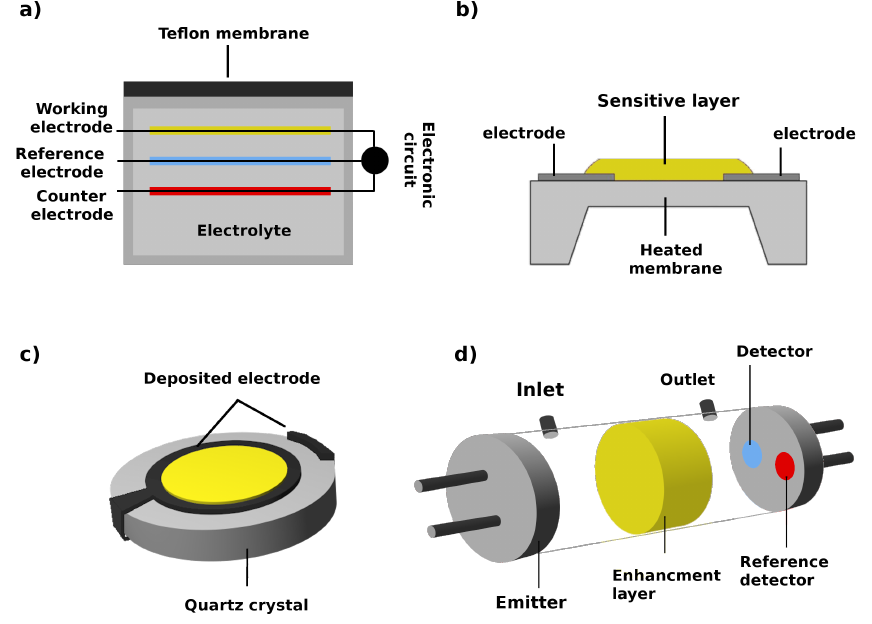
Figure 3. Principles of detection used for chosen gas sensors applied in e–noses: ( a ) electrochemical, ( b ) chemiresistive, ( c ) piezoelectric, ( d )